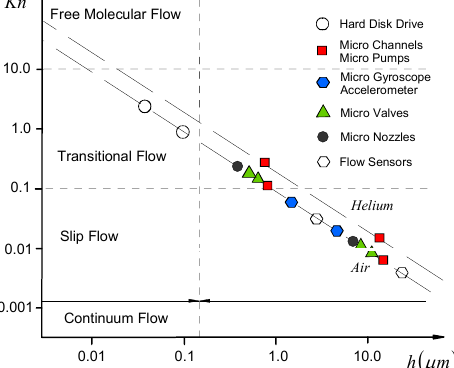
Fig. 1: Classification of flow regimes of MEMS devices based on the Knudsen number; see also Karniadakis et al.